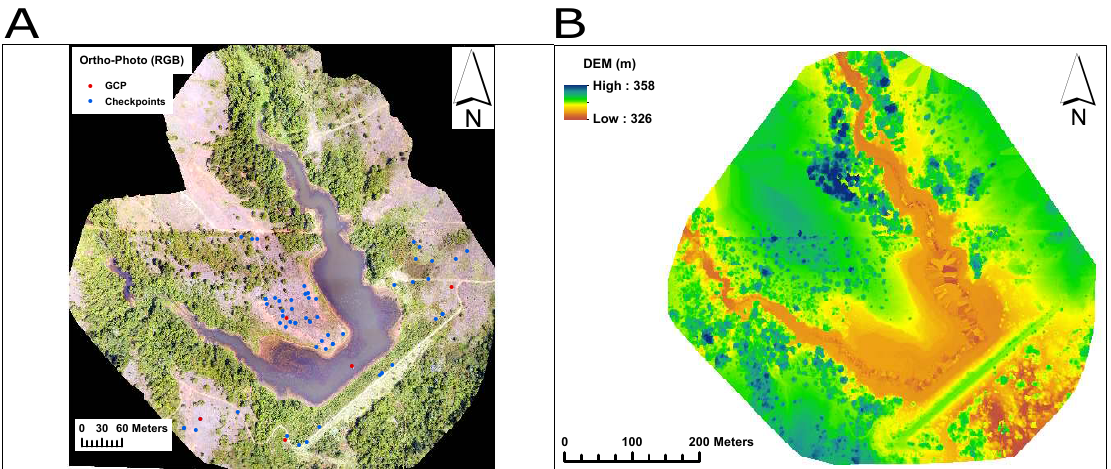
Figure 7. ( A ) location of checkpoint and Ground Control Points (GCPs) collected with a total station survey. The figure overlays the georeferenced orthophoto ( B ) derived Digital Elevation Model (DEM) with the Pix4DMapper Pro R (cid:13) software.